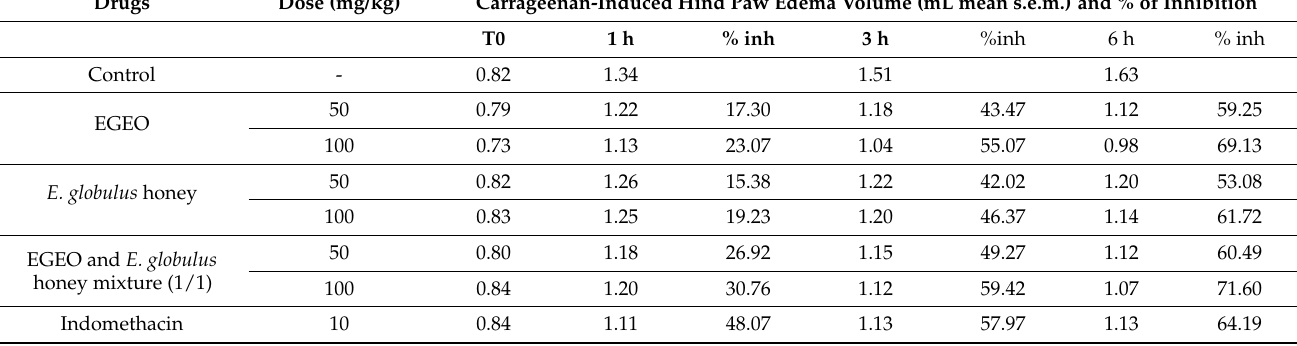
Table 5. Inhibition percentage of the left hind paw volume in rats treated with EGEO, E. globulus honey, and their